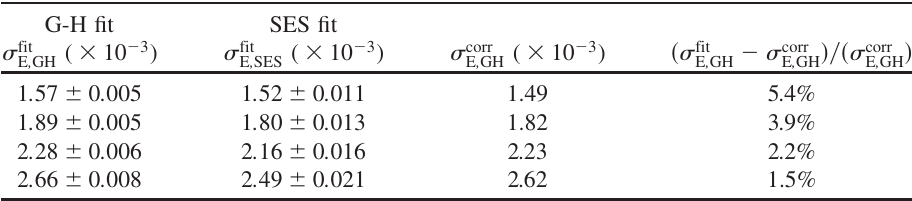
TABLE II. Fitted values of the energy spread with N emittance correction. The corrected energy spread is given by (cid:1) corr E